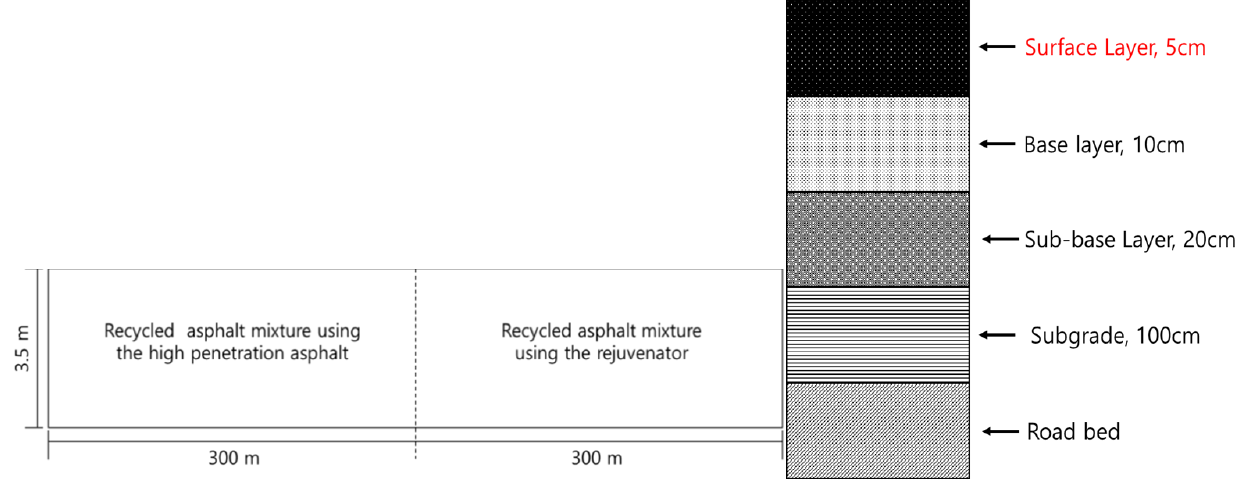
Figure 7. Schematic diagram of test field construction and cross-section.